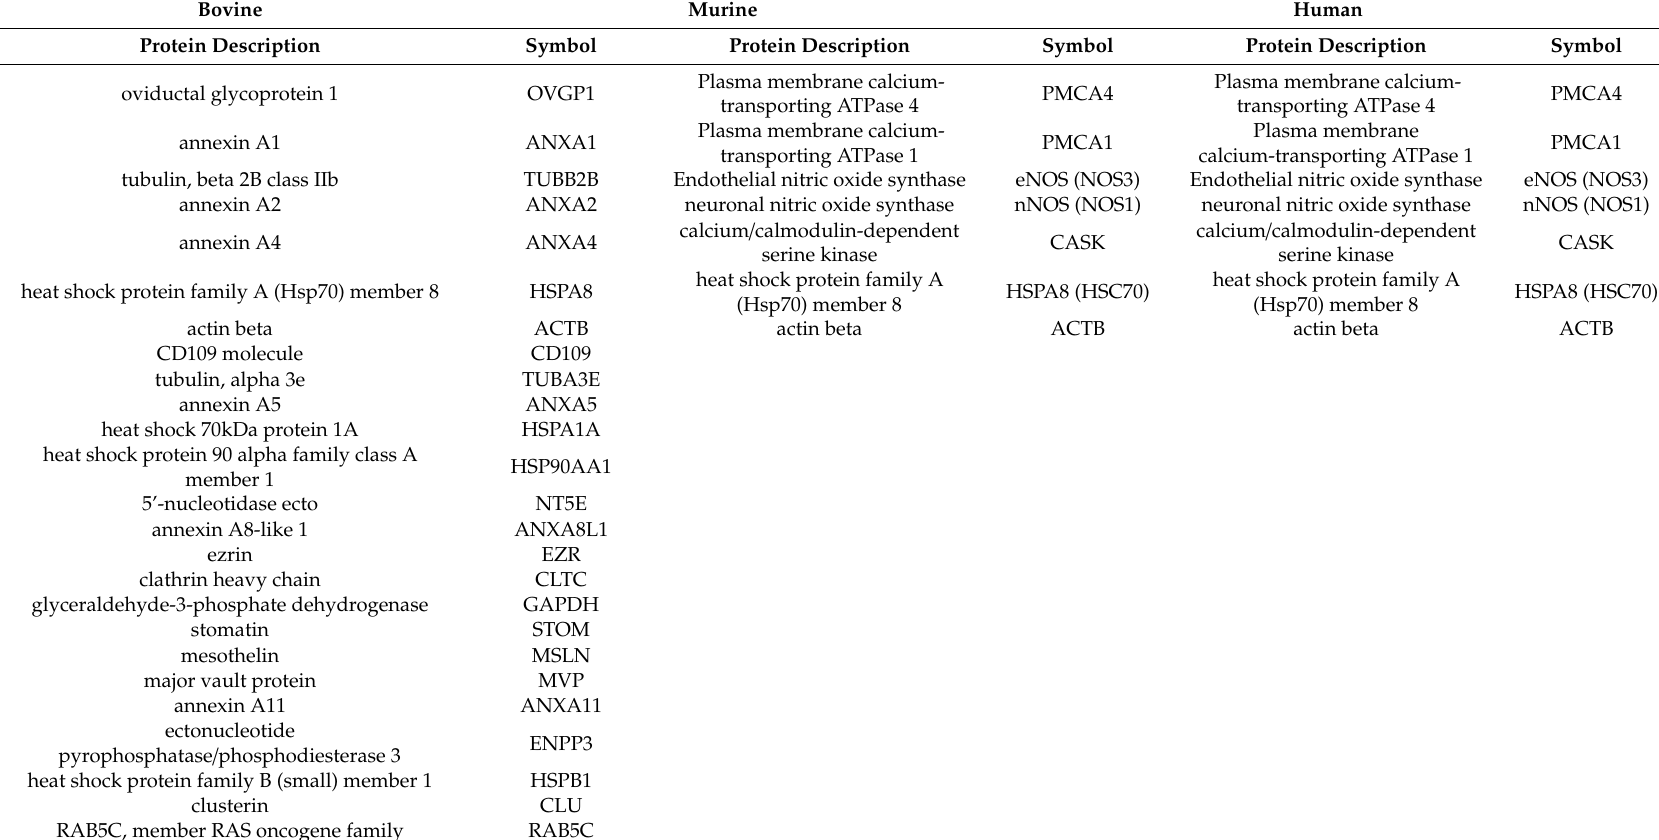
Bovine: Only the 25 most abundant proteins are shown in the table. A complete list of the bovine oEVS proteins identified by Mass Spectrometry so far can be found in Almiñana et al., 2018. Murine: Murine oEVs proteins have been identified by Western blot immunolabeling (source: Bathala et al., 2018). Human: Human oEVs proteins have been identified by Western blot or immunolabeling (source: Bathala et al.,